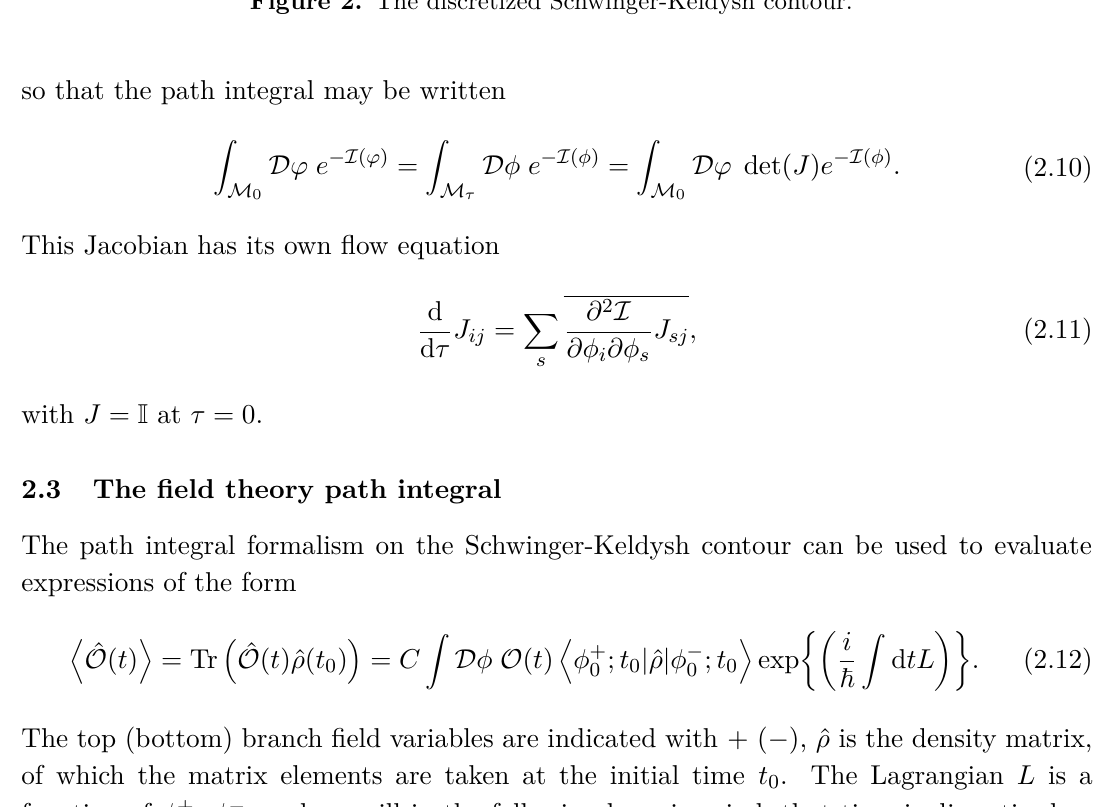
Figure 2. The discretized Schwinger-Keldysh